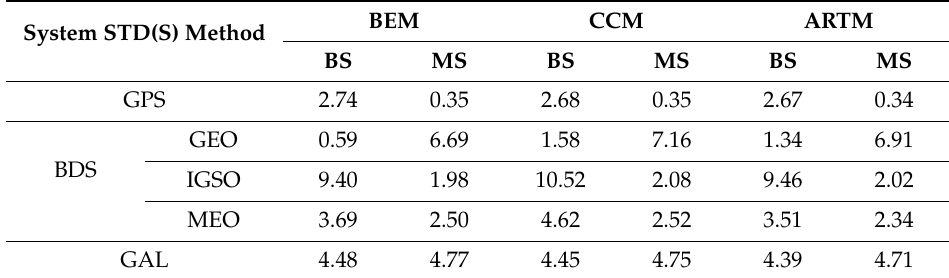
Table 2. The STD of the GPS, BDS, and GAL systems, which was calculated by the three methods. BS denotes the STD between the satellites for the same system, and MS denotes the STD of the mean shift time for the same